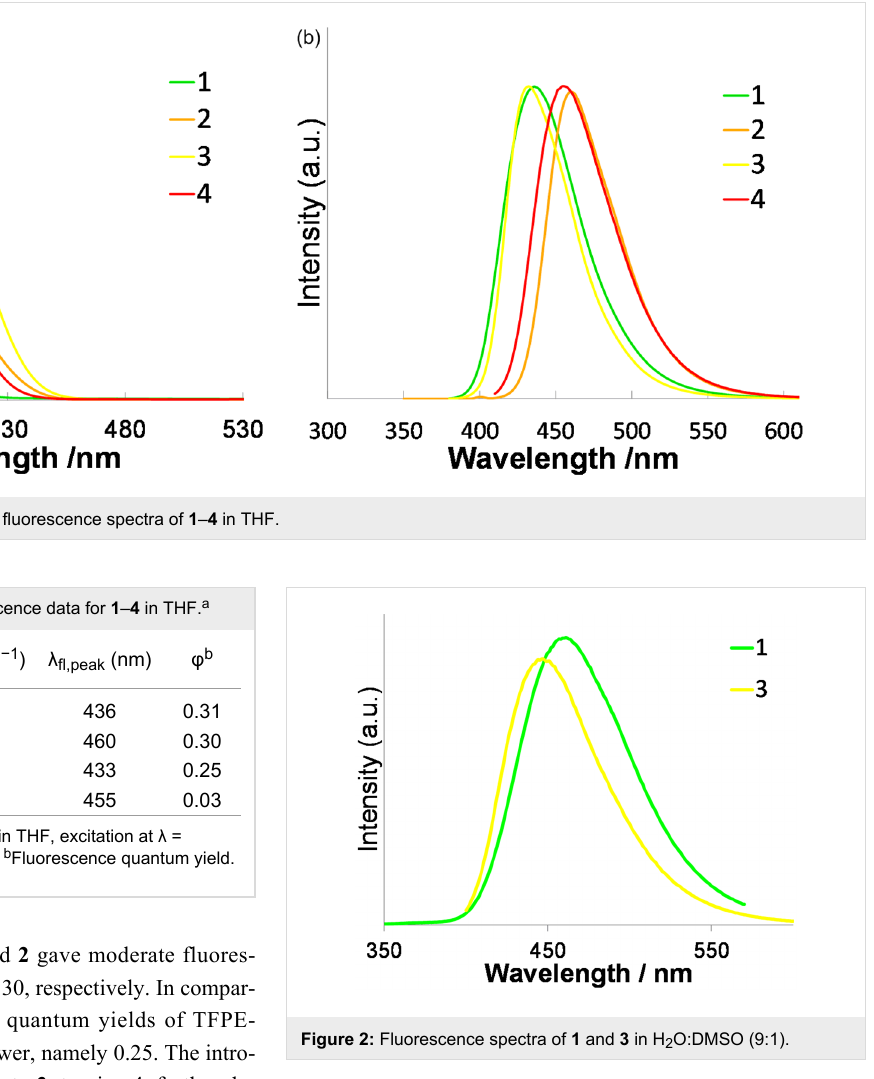
Table 3: Fluorescence data for 1 – 3 in H 2 O:DMSO (9:1). a λ fl,peak